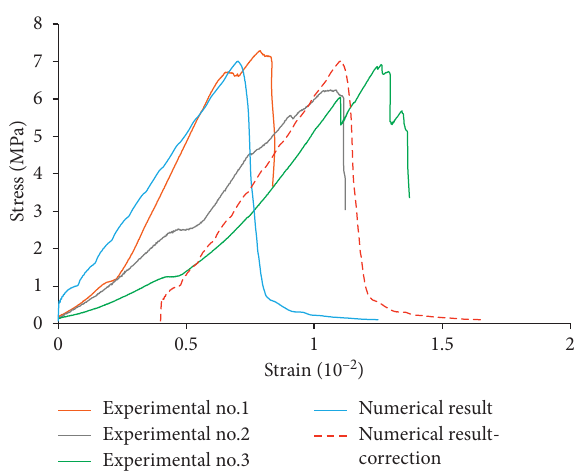
Figure 9: Stress vs. strain experimental and numerical curves for coal